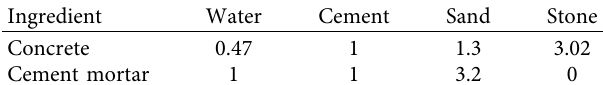
Table 1: Mix proportions of concrete and cement mortar in a test. Ingredient